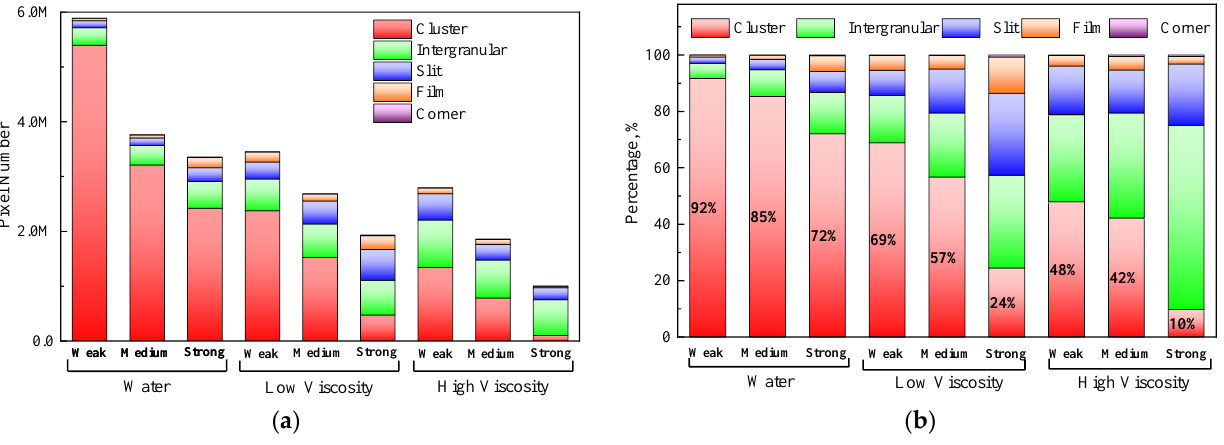
Figure 10. The occurrence of the remaining oil at different injection rates. ( a ) The remaining oil content; ( b ) the proportion of the remaining oil.